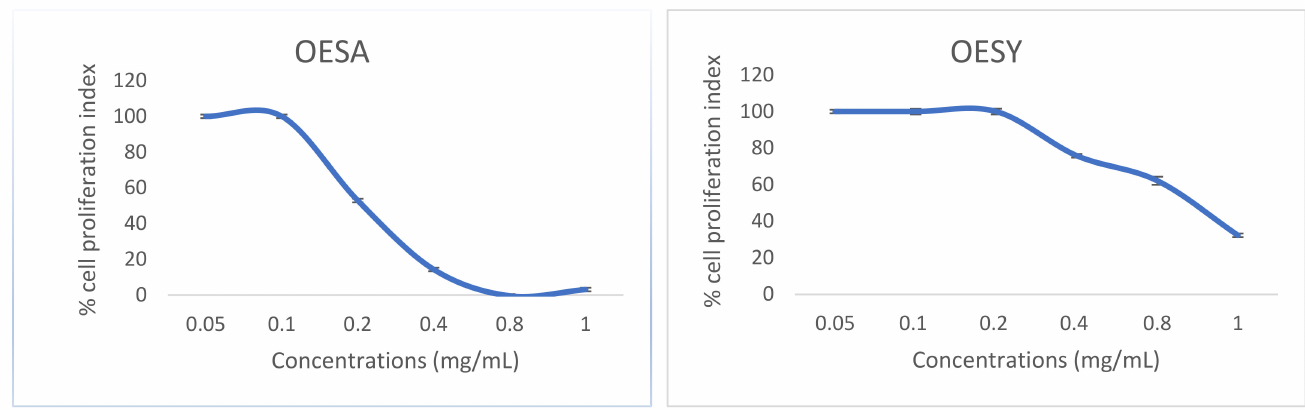
Figure 2. Viability assay in Vero cells treated with olive leaf extracts OESA and OESY. Vero cells were treated with different concentrations of olive leaf extracts (0.05 mg/mL, 0.1 mg/mL, 0.2 mg/mL, 0.4 mg/mL, 0.8 mg/mL, 1 mg/mL). The cells were collected 72 h post-treatment, and the luminescence value was converted into the cell proliferation index (%) as described in the Materials and Methods section. The assay was performed as the means of triplicates ± SD. OESY, extract of O. europea var. sylvestris; OESA, extract of O. europea var. sativa.